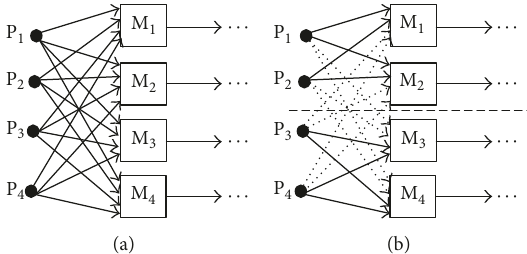
Figure 8: MPC consisting of (a) two machines and four parts and (b) two machines and four parts divided into two groups with one machine and two parts for one